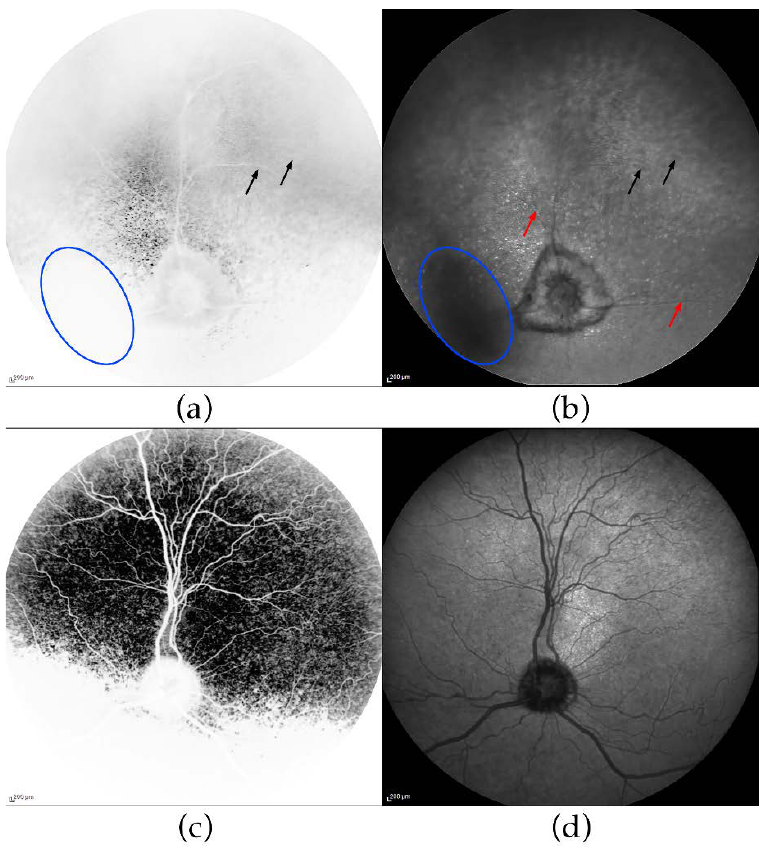
Figure 1. Fundus autofluorescence (FAF) and infrared confocal scanning laser ophthalmoscopy (IR-cSLO). cSLO FAF- and IR-cSLOs of the left eye of GR02 (panels ( a , b ), respectively) and age-matched, unaffected Labrador retriever LR01 (panels ( c , d ), respectively). Both FAF-images are inverted and hence, the tapetal reflection in GR02 ( a ) is remarkably faint. Detection of FAF in the tapetal fundus is difficult because of the normal, bright reflection from the tapetum lucidum. Black arrows indicate areas with bright reflection in the tapetal fundus on FAF ( a ), but hyporeflection on IR ( b ), which is suggestive of lipofuscin accumulation. The slight hyperreflection (the grey shade below the optic nerve head in the inverted image) ( a ) in the non-tapetal area autofluorescence indicates storage of lipofuscin. The IR-image ( b ) shows the large, myelinated optic nerve head often seen in the golden retriever breed, but very attenuated retinal vessels (red arrows) and islets of hyperreflectivity. Cast shadows in the cSLOs from GR02 were caused by the cataracts present in this dog (one shadowed area indicated by the blue oval).